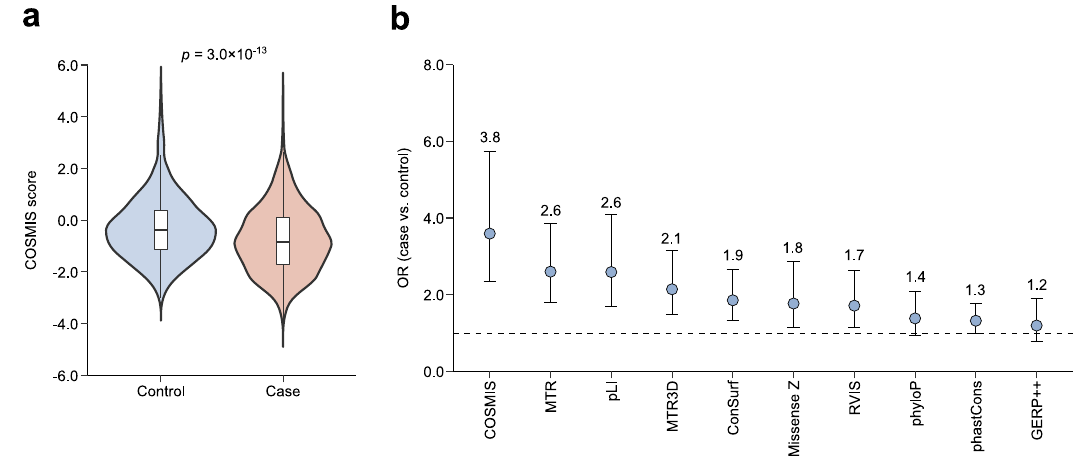
Fig. 7 COSMIS score improves interpretation of de novo missense mutations from neurodevelopmental disorders. a COSMIS score distributions for de novo missense mutations from neurodevelopmental disorder cases (Case) and from unaffected siblings of autism spectrum disorder probands (Control). Case variants ( n = 2271) have a signi fi cantly more constrained spatial neighborhoods than control variants ( n = 571) (median COSMIS − 0.83 vs. − 0.39, p ¼ 3 : 0 ´ 10 (cid:1) 13 , two-sided Mann – Whitney U test). b Case variant enrichment analysis for intra- and inter-species constraint metrics at the 10 th percentile of most constrained sites. COSMIS has the highest enrichment for cases (OR 3.6, 95% con fi dence interval [2.3, 5.7]). Error bars are 95% con fi dence intervals of ORs. Results of this OR analysis are consistent across thresholds other than the 10 th percentile (Supplementary Fig. 9). The values for each cell of the contingency table used for the OR calculation in each percentile bin were reported in Supplementary Data 15. OR odds ratio. Source data are provided as a Source Data fi